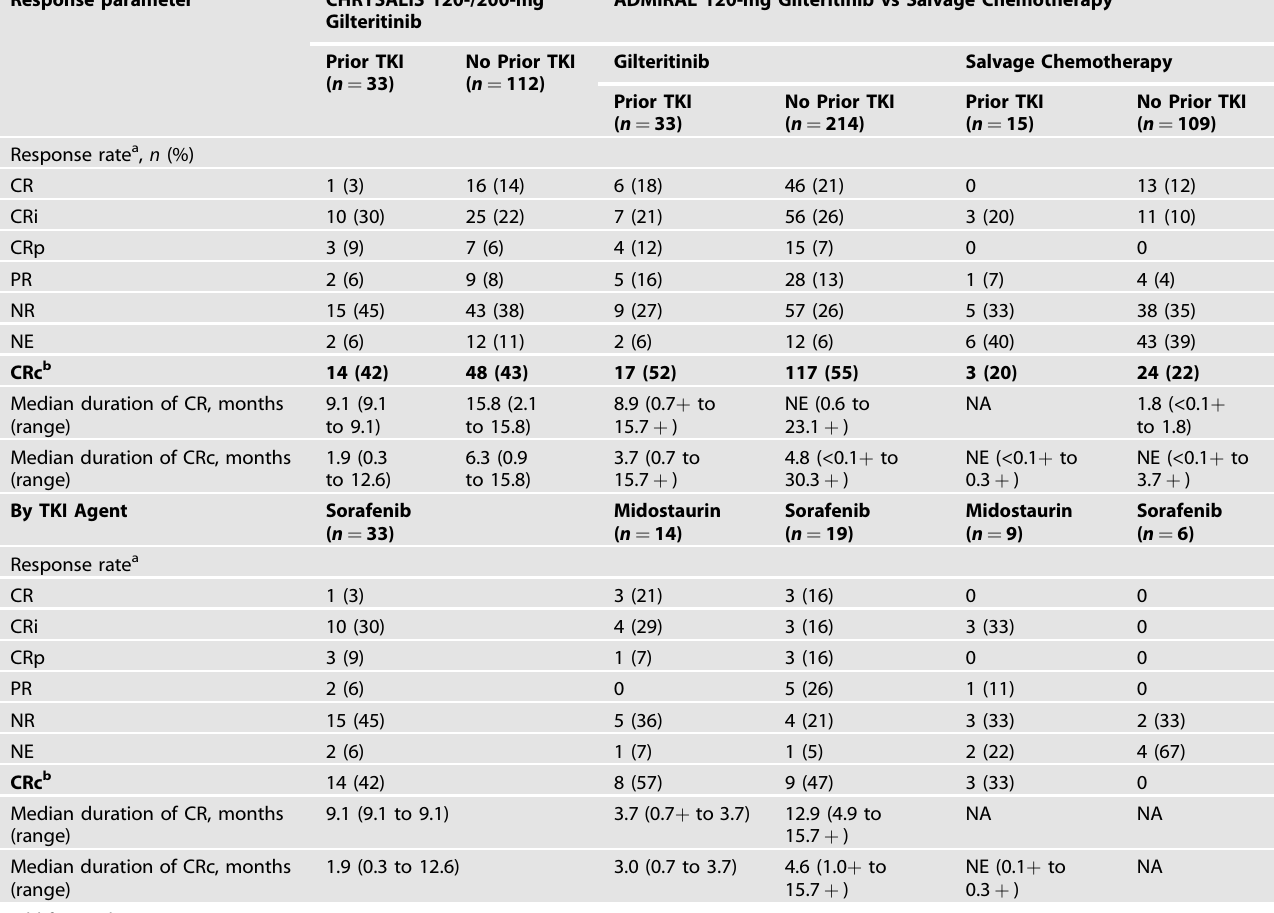
Table 2. Response outcomes in patients with R/R AML based on prior TKI therapy status in the CHRYSALIS and ADMIRAL trials. Response parameter CHRYSALIS 120-/200-mg